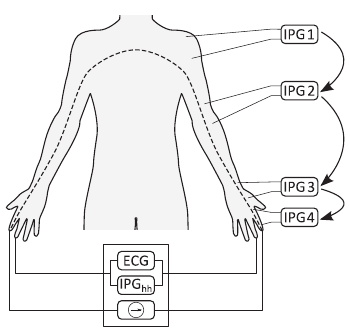
Fig.3: Setup for the hand-to-hand IPG